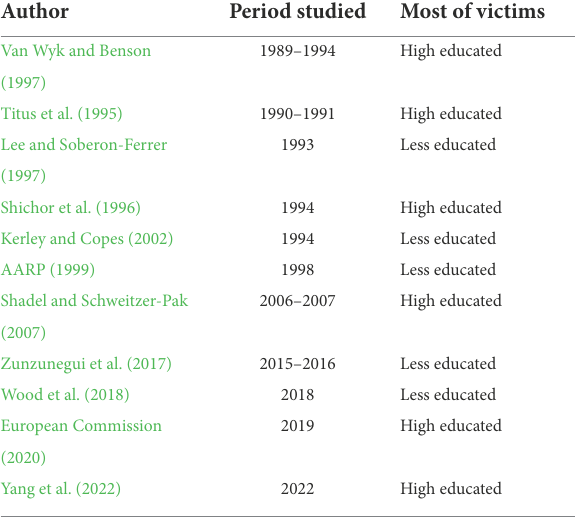
TABLE 3 Profiles of victims according to education across